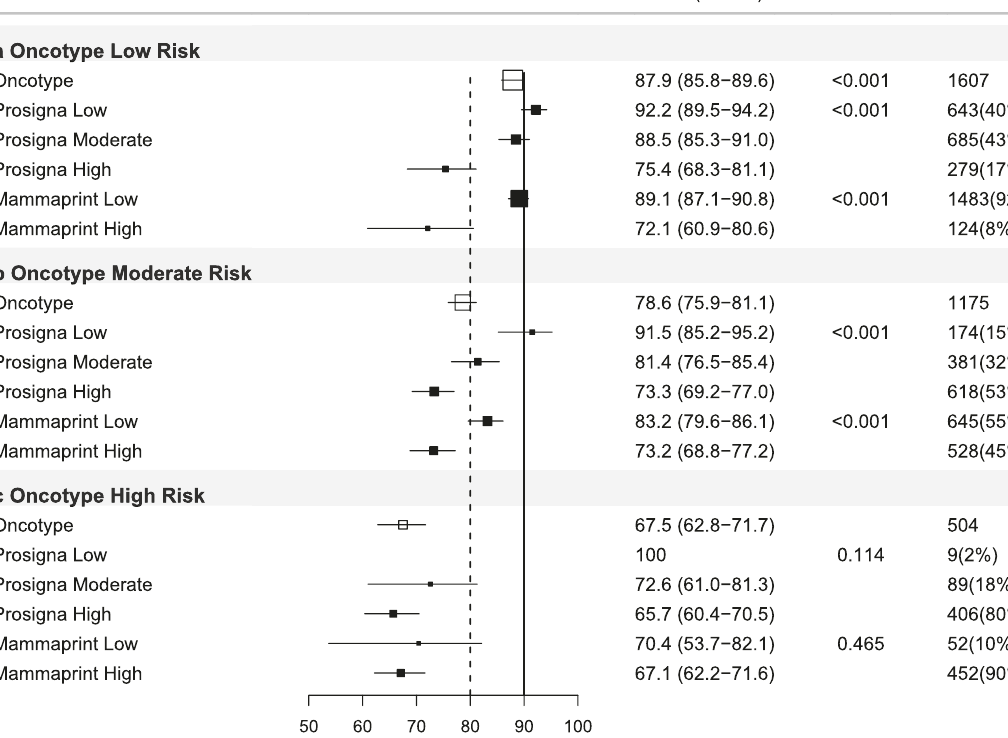
Fig. 2 Forest plot of Oncotype-trained test results re-strati fi ed by other tests, all ER + ve/HER2 − ve cases. DMFS10 = distant metastasis free survival at 10 years post diagnosis. (95% CI) = 95% con fi dence interval, P value = p value, N = number of cases in each subgroup, % = percentage of cases within each risk strata. X axis = percent distant metastasis free survival. Open boxes represent primary test DMFS10 by risk group. Solid boxes represent sub-strati fi cation by secondary tests with 95% con fi dence intervals (bars). Top panel ( a ) oncotype-trained low risk cases strati fi ed by prosigna-trained and Mammaprint-trained results. Middle panel ( b ) oncotype-trained moderate risk group. Bottom panel ( c ) oncotype-trained high risk